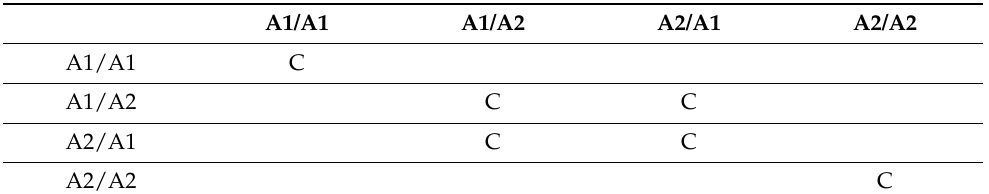
Table 1. Compatibility between 37.5% of randomly selected heterokaryons variable at a single biallelic locus. Squares with the letter C indicate compatible heterokaryons.